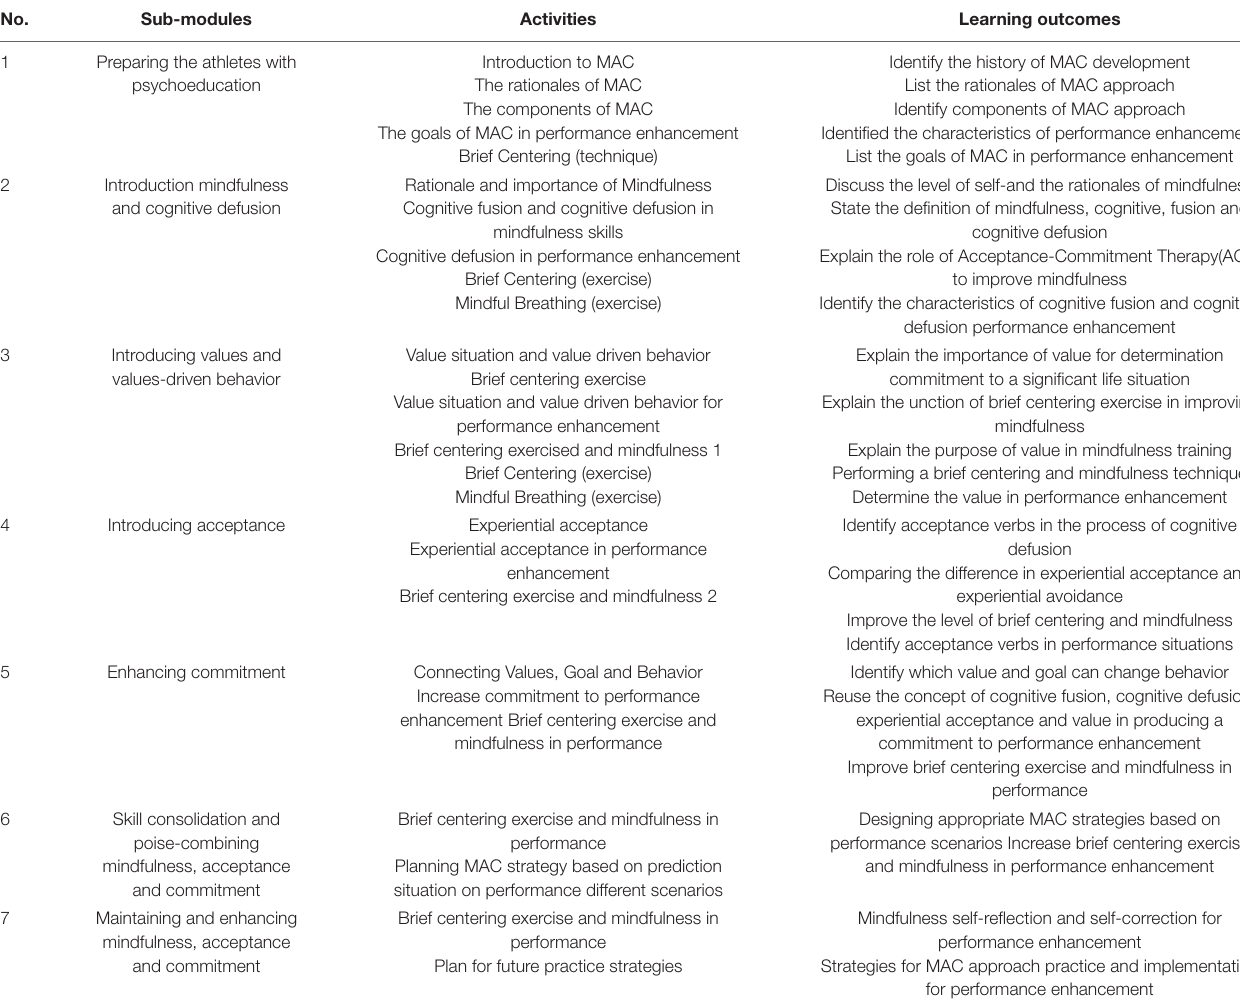
TABLE 2 | Mindfulness Acceptance Commitment (MAC) 7-module content and learning outcomes done over 7 weeks of training.